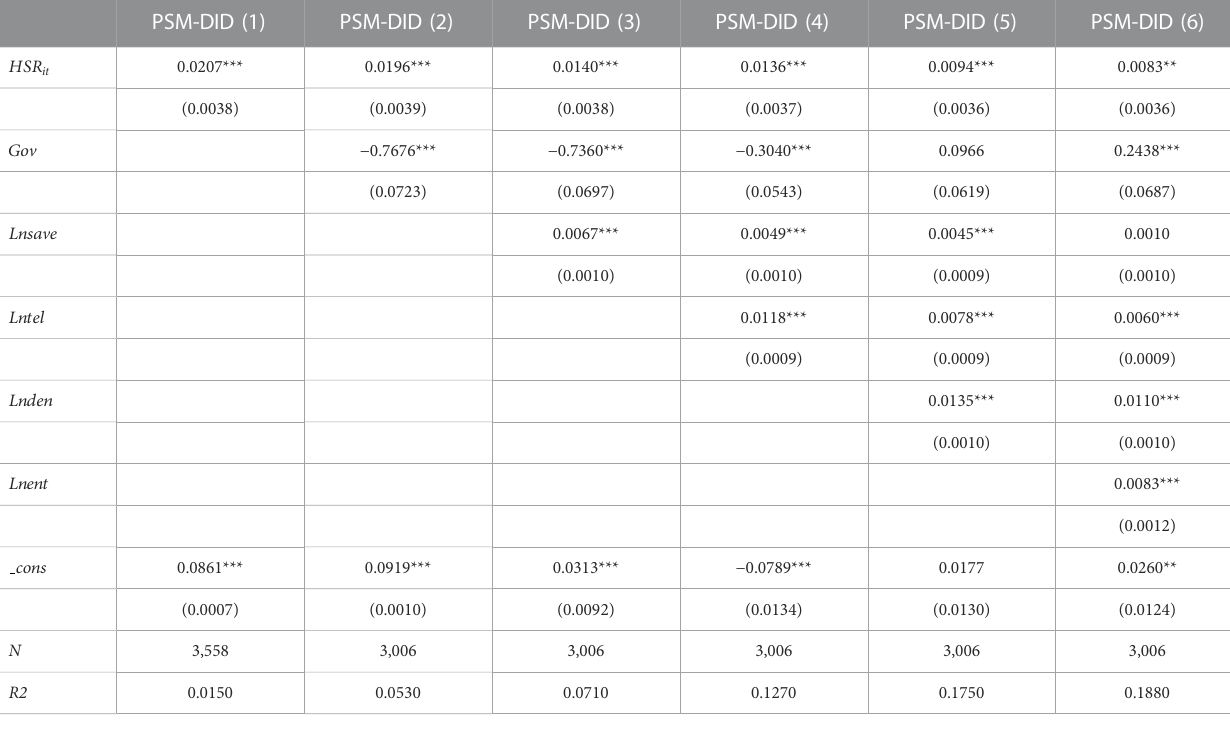
TABLE 10 Two-stage 2SLS estimation of instrumental variables.